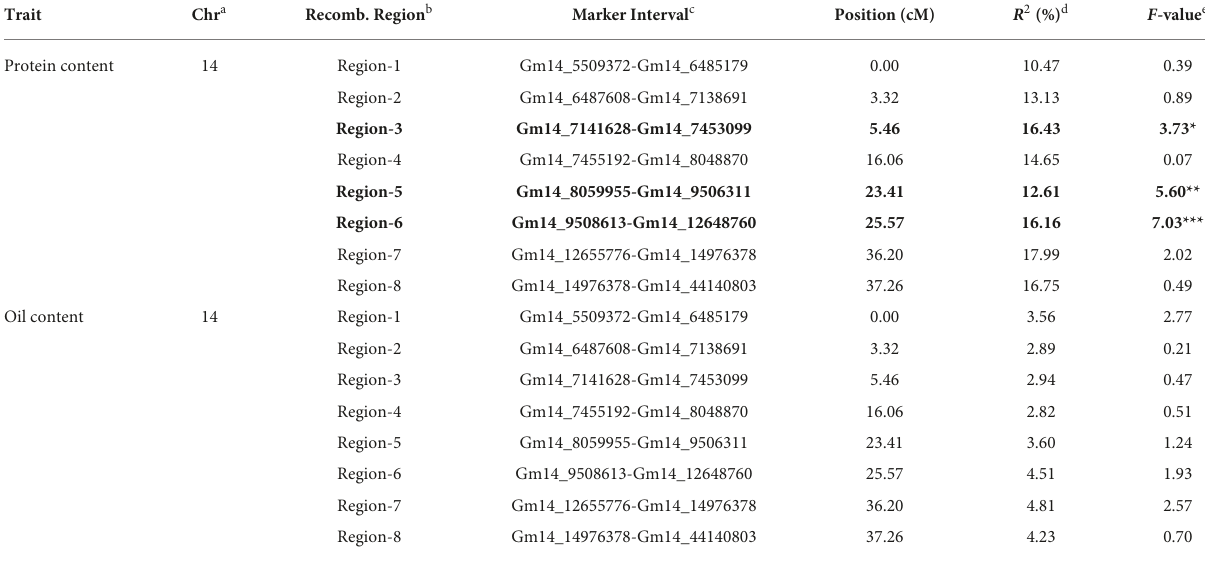
TABLE 5 The eight recombination regions for seed protein and oil on Chr.